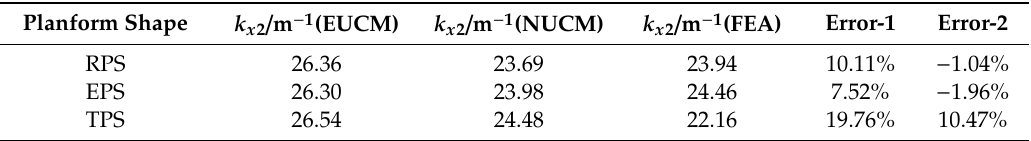
Table 6. Principal curvature of anti-symmetric cylindrical shells with di ff erent planform shapes from analytical model and